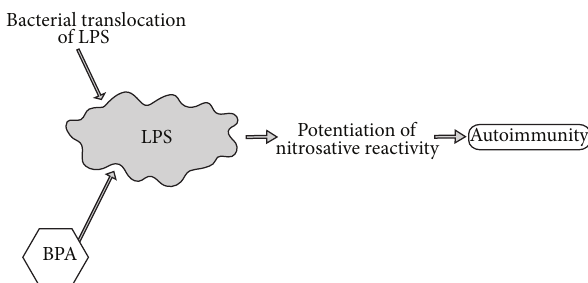
Figure 8: This diagram illustrates how bisphenol A can promote lipopolysaccharide inflammatory sequelae. BPA: bisphenol A; LPS: lipopolysaccharide. cytokine modulation may be part of the immunopathology of BPA autoimmune development.